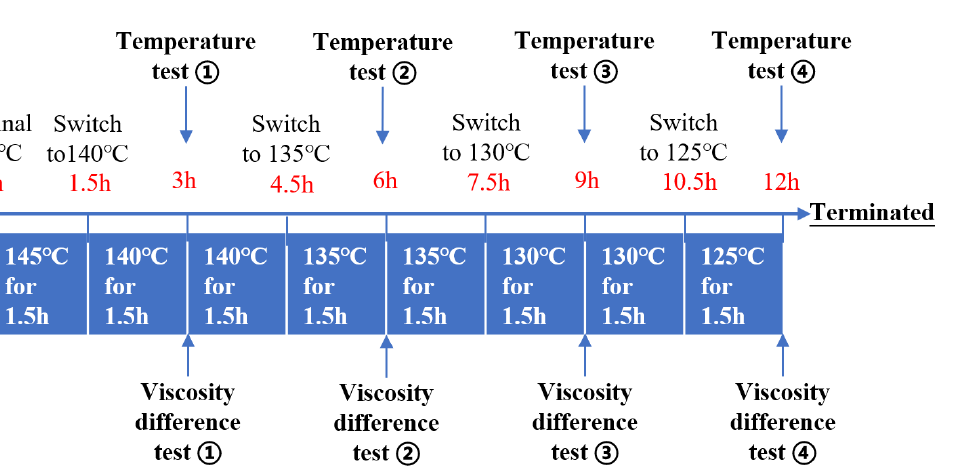
Figure 21. Outline of simulated experiment for the storage stability during transportation.